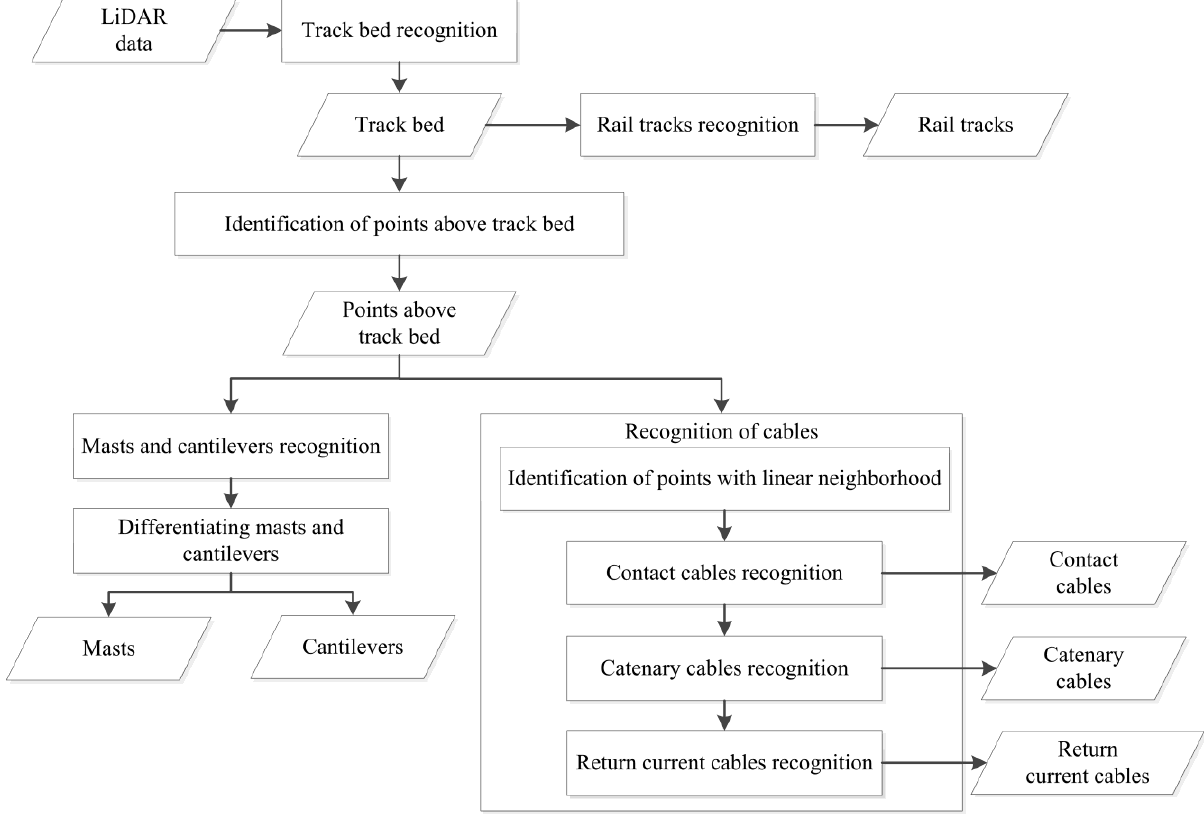
Figure 2. Flowchart of the proposed